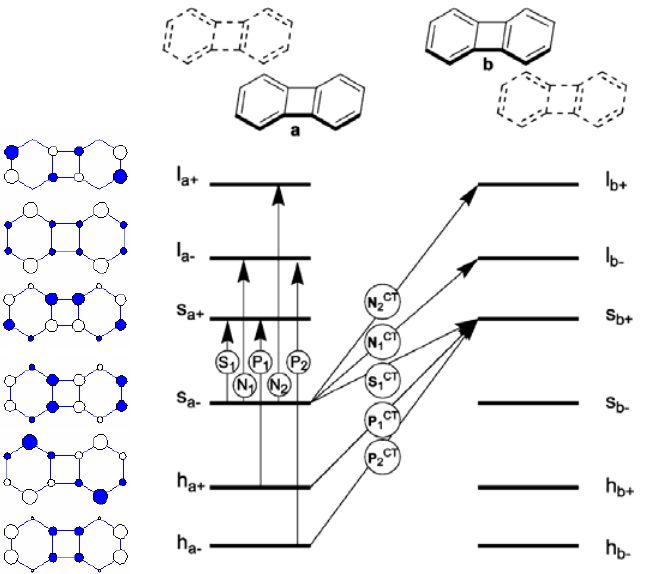
Figure 9. Hückel MO’s of the J-aggregated biphenylenes, their energies, perimeter labels, and the five singly excited configurations responsible for the S [51]. Reproduced with permission from American Chemical